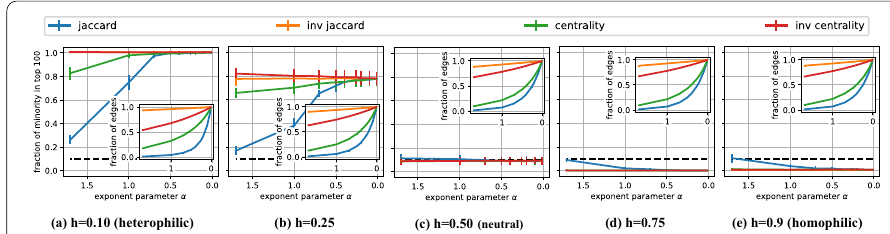
Fig. 4 Impact of structure-based noise on the representation of minority nodes in rankings on synthetic networks. Similar to Fig. 3 we visualize the fraction of the minority as a function of the noise strength represented via α . Larger values of α correspond to higher noise-values (noise decreases from left to right in every subplot). The insets show the impact of noise on the number of edges in the network. As the noise is not aligned with the relative group connectivity regulated by the homophily parameter h , we can see that the general amount of edges dropped for each noise type is relatively independent of h . Although centrality-based noise leads to omitting comparatively many edges, the impact of centrality noise on the representation of the minority in the degree ranking is not as strong as Jaccard